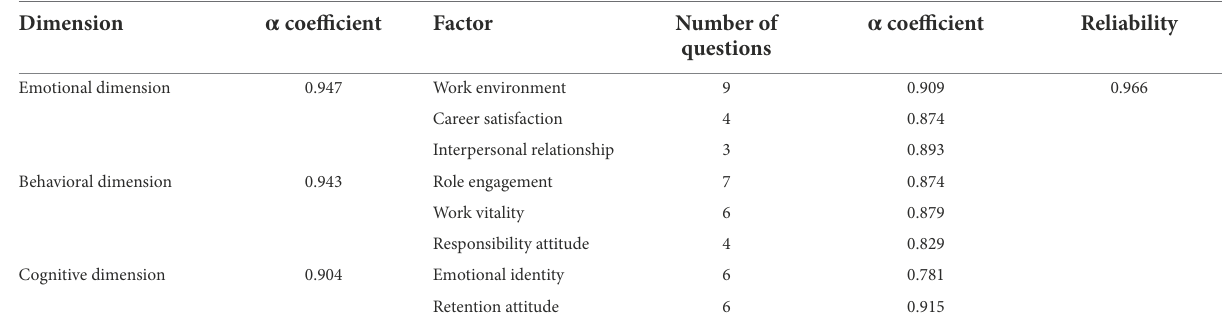
TABLE 2 The overall scale, the homogeneity coefficient of each dimension, and each factor. Total table (45 items) α coefficient: 0.966